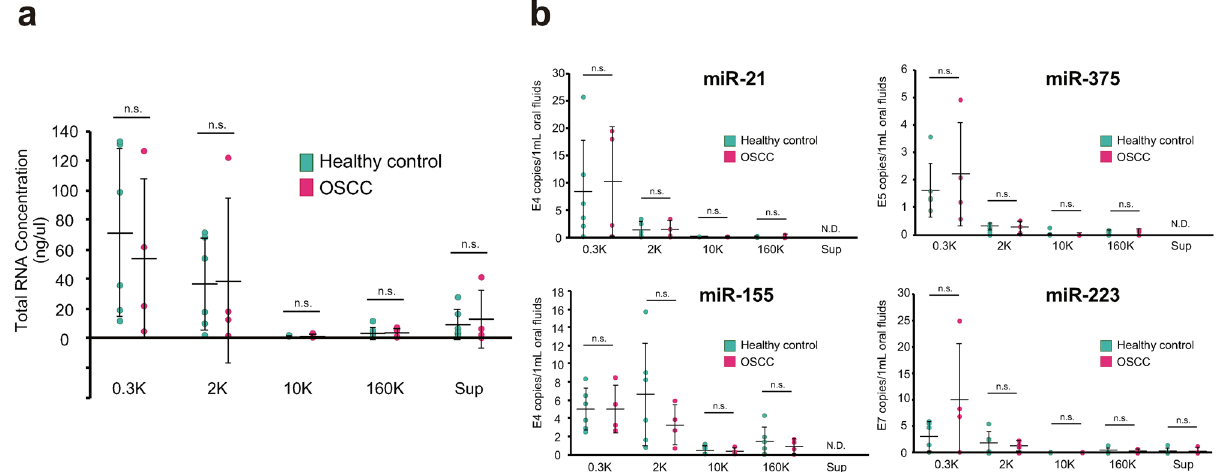
Figure 4. Distribution of RNA molecules among pentapartite fractions from oral fluids (OFs). ( a ) Total RNA concentration in each fraction from 6 healthy volunteers (green dots) and 4 patients with OSCC (red dots) estimated by Bioanalyzer. Each dot represents the mean value obtained from three measurements. ( b ) Copy numbers of miR-21, miR-375, miR-155, and miR-223 in each fraction were determined using chip-based Quant Studio 3D digital PCR. Green and pink dots indicate the mean values of the three measurements in 6 healthy volunteers and 4 patients with OSCC, respectively. The mean value of groups is represented as solid horizontal lines. The two-tailed unpaired t-test was used to evaluate statistical significance. n.s. not significance, p > Fig. S12b) both from OSCC2 and from OSCC4 (shown by asterisks in Fig. S12b), whereas only the one in OSCC4 was detected by the N-terminal specific antibody. A further complicating observation was detection of the appar-